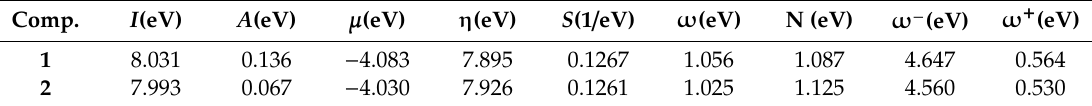
Table 3. Global indices of reactivity: ionization potential ( I ), electron a ffi nity ( A ), chemical potential ( µ ), global hardness ( η ), global softness ( S ), electrophilicity index ( ω ), nucleophilicity index ( N ), electron donating power ( ω − ), and electron accepting power ( ω +